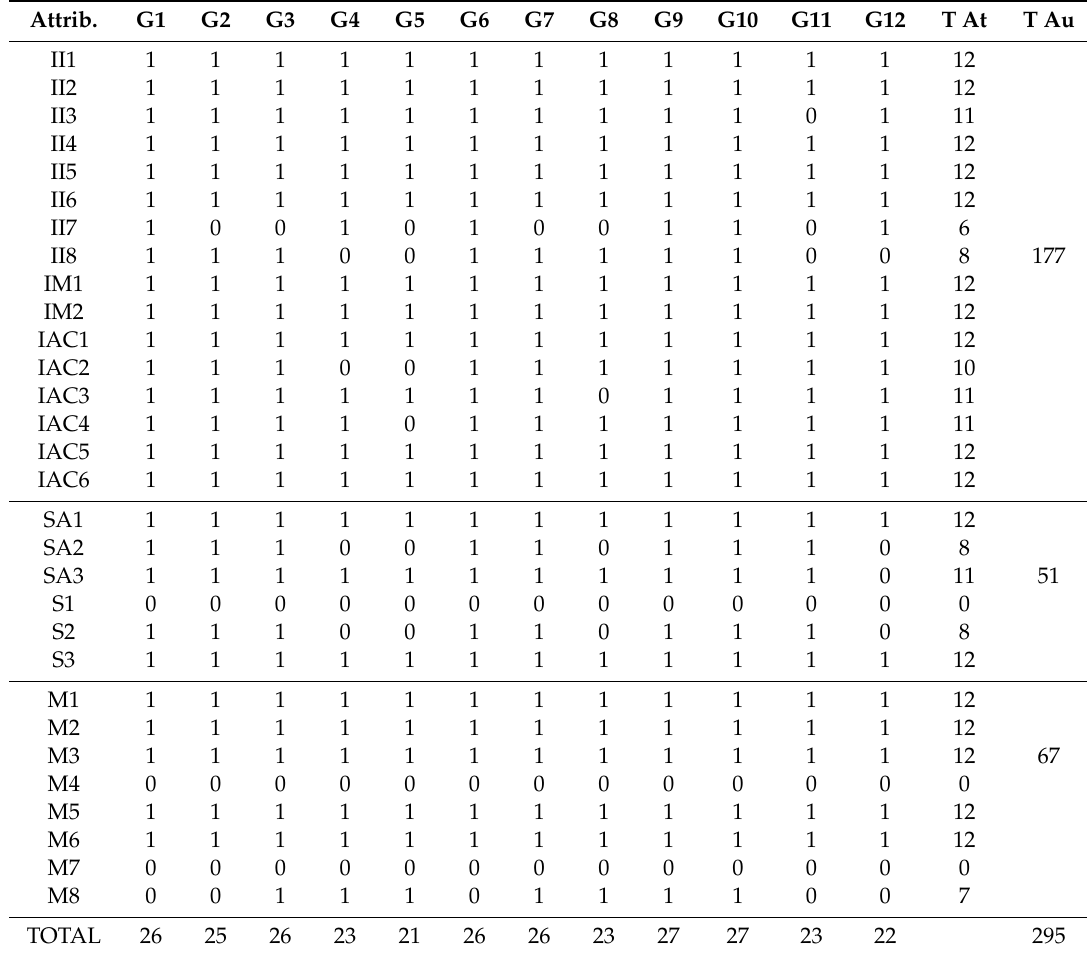
Table 4. Categorization results of the didactic